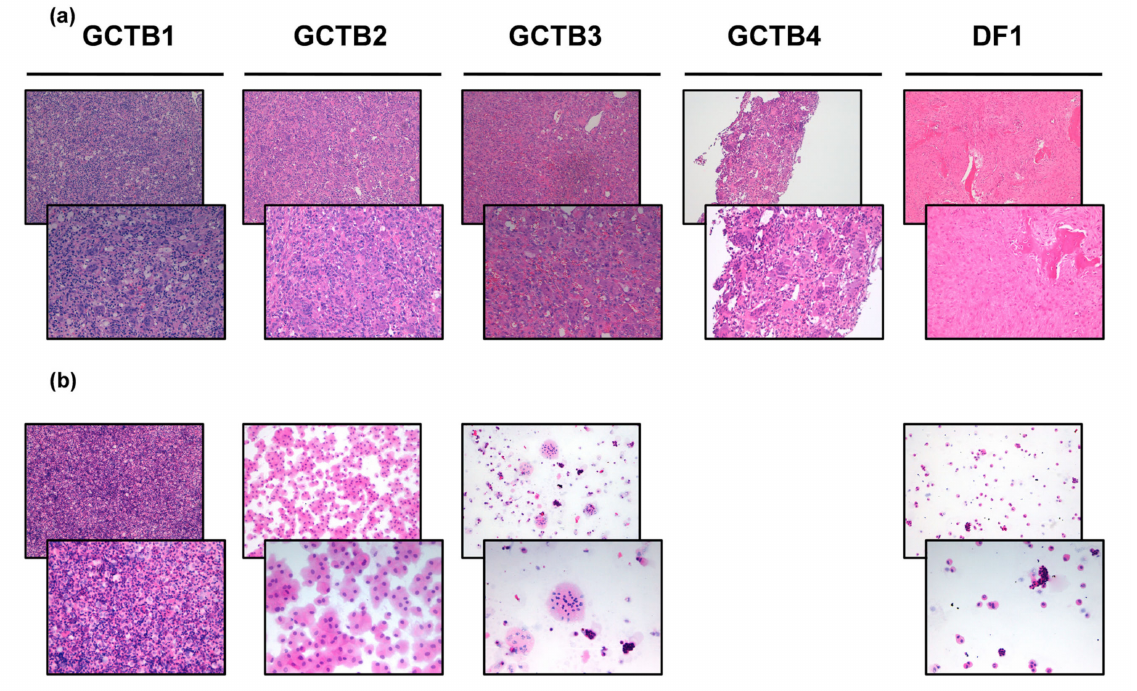
Figure 1. ( a ) H&E of the patient’s surgically resected tumor specimen (10 × and 20 × magnification). ( b ) H&E of the patient-derived primary culture (10 × and 20 × magnification). Macroscopic evaluation of surgically resected right distal tibia tumor tissue of pa- 9 × 8 × 2 cm. Hematoxylin and eosin-stained tumor tissue (Figure 1A) reviewed by